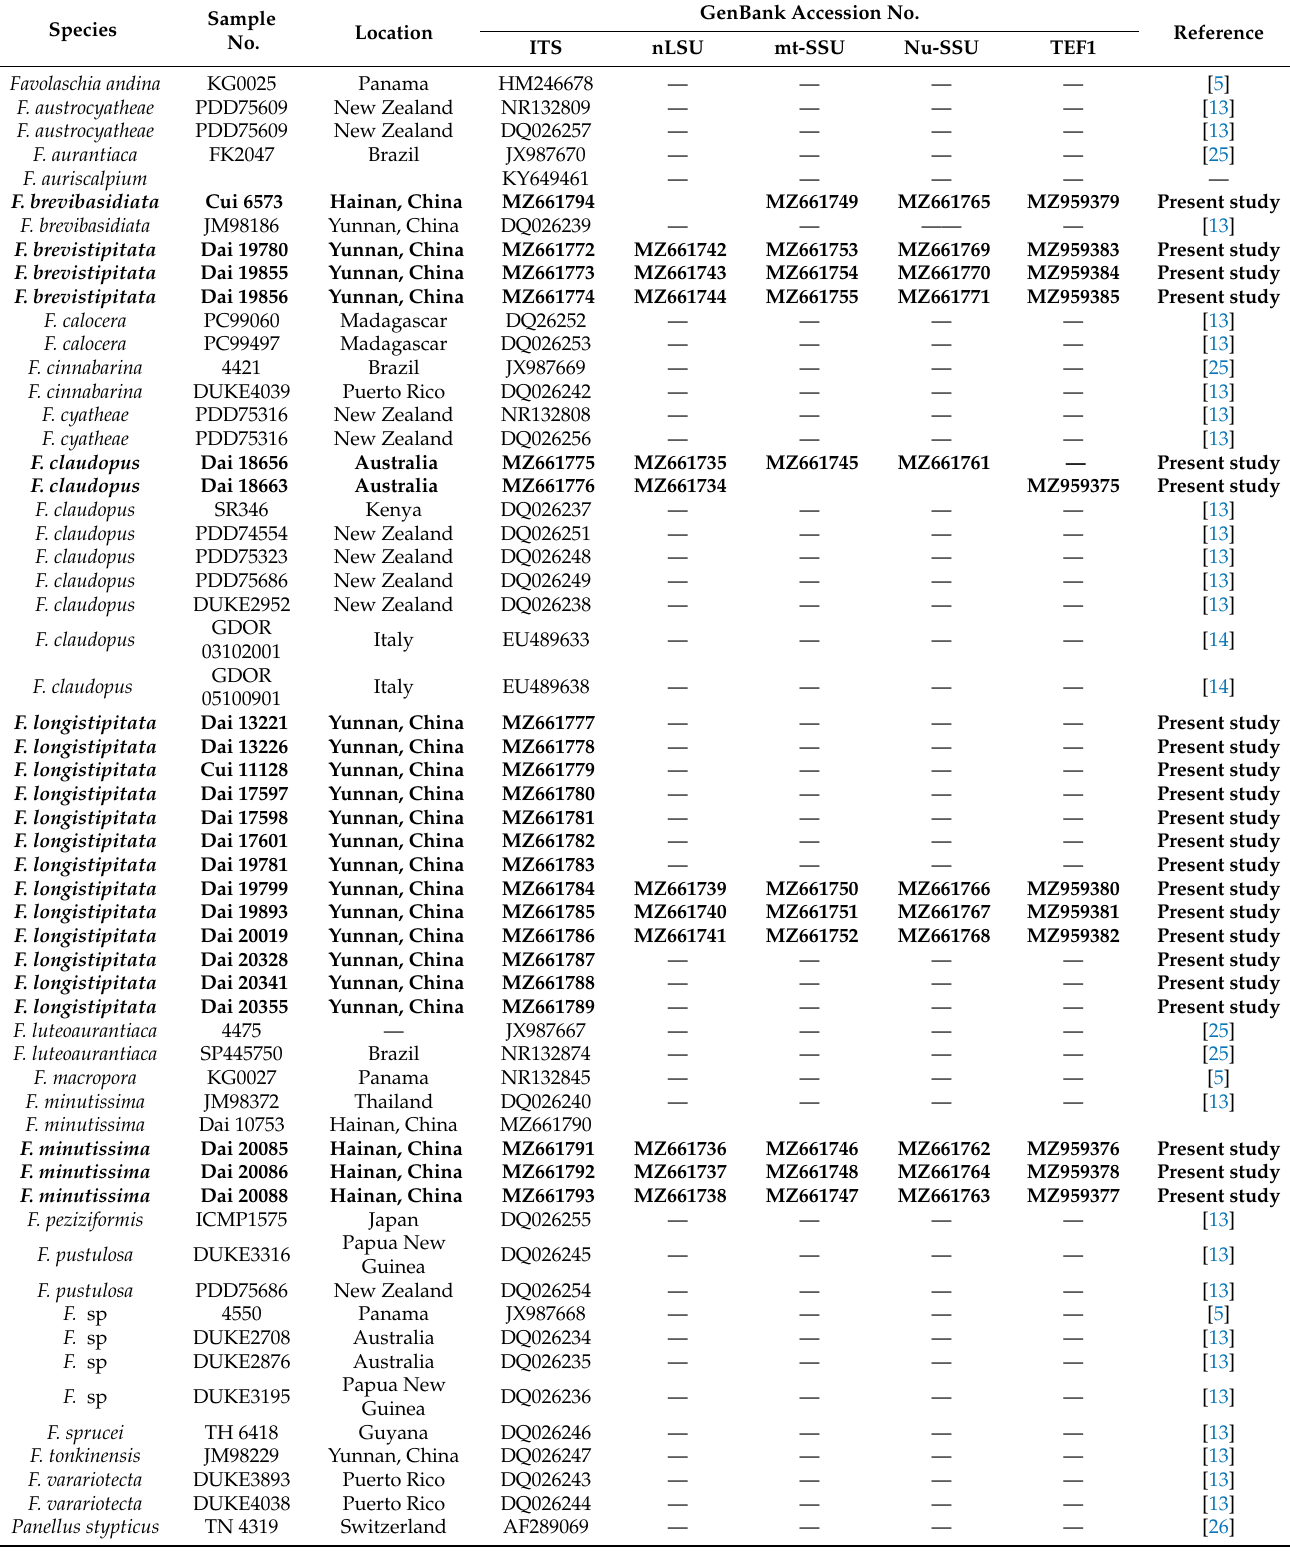
GenBank Accession No.